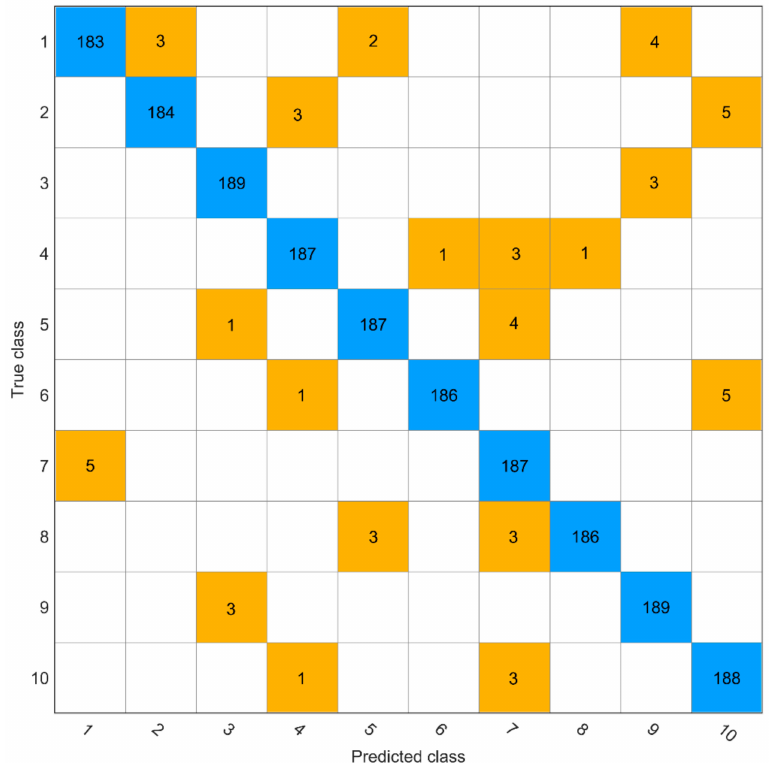
Figure 2. Confusion matrix. (1) Nannong 1606; (2) Shangdou 161; (3) Shangdou 1201; (4) Shangdou 1310; (5) Yudou 18; ( 6 ) Yudou 22; (7) Yudou 25; (8) Zheng 196; (9) Zheng 3074; and (10) Zheng